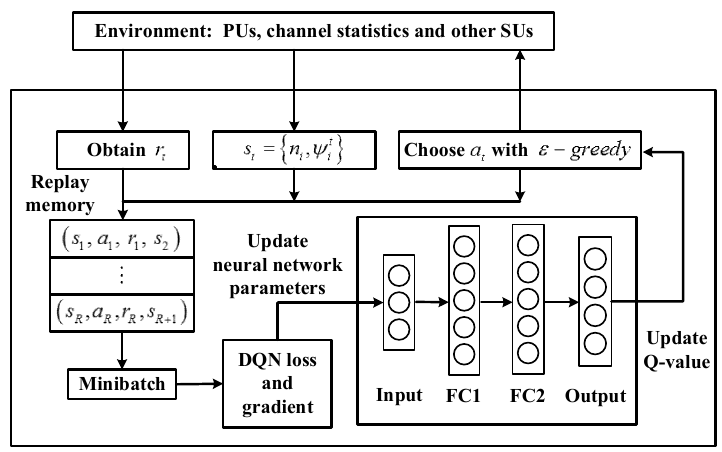
Figure 2. Implementation of memory optimization for the replay buffer.